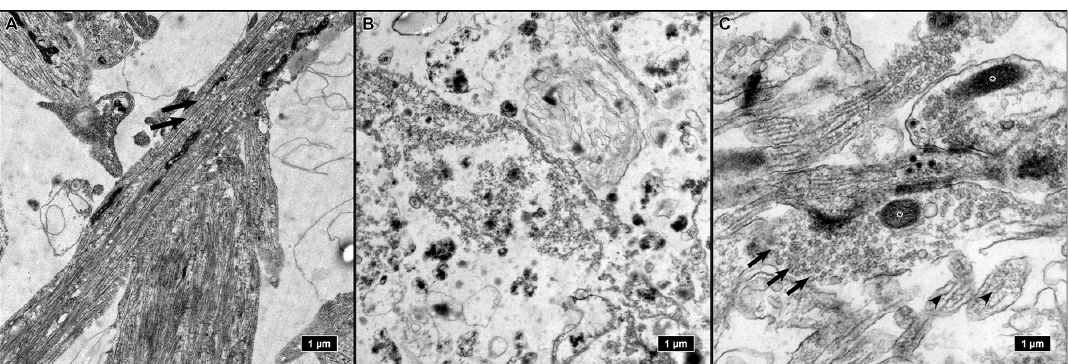
Figure 2. Ultrastructure of the three di ff erentiation modalities: Adherent di ff erentiation on coverslips resulted in the loss of all neuronal cells after sample preparation for transmission electron microscopy (TEM). Only astrocytic processes with intermediate filaments (arrows) were preserved ( A ). Spheres embedded in Matrigel exhibited a fragmented ultrastructure with low preservation of integrity ( B ). Only neurospheres provided preservation of neuronal elements, such as synapses, with vesicles (arrows), and synaptic mitochondria (asterisks), and neurites with neurofilaments (arrowheads) ( C